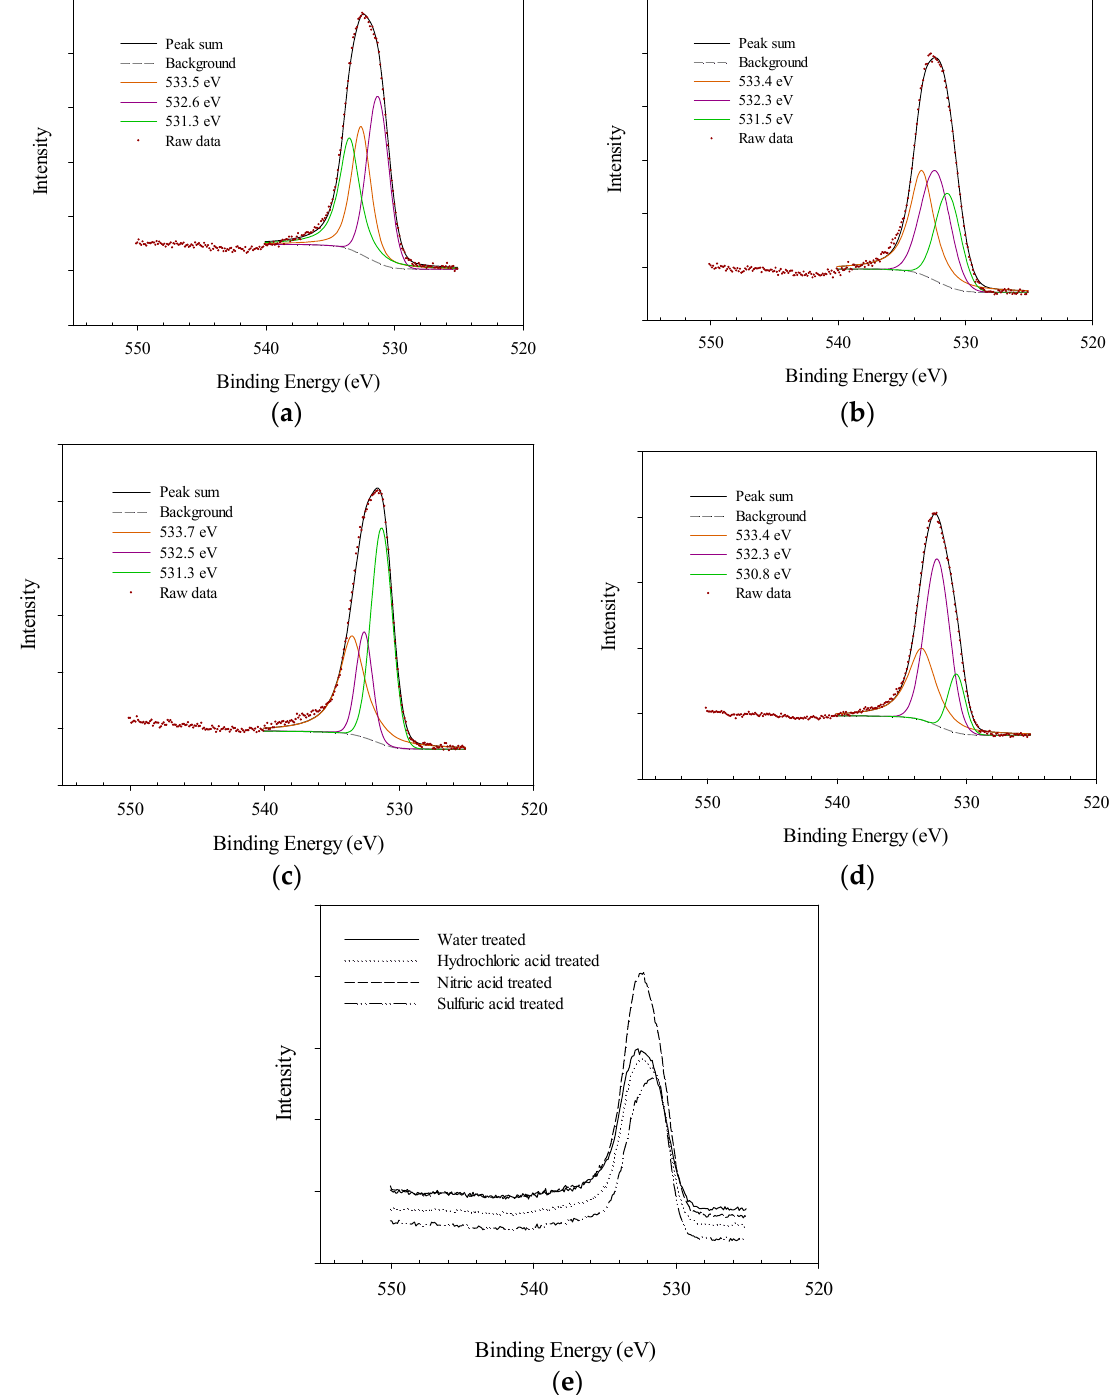
Figure 4. XPS spectra of oxygen 1s peak for different AF 5 treatments: ( a ) Water-treated ( b ) Hydrochloric acid-treated, ( c ) Sulfuric acid-treated, ( d ) Nitric acid-treated, ( e ) Raw data comparison.